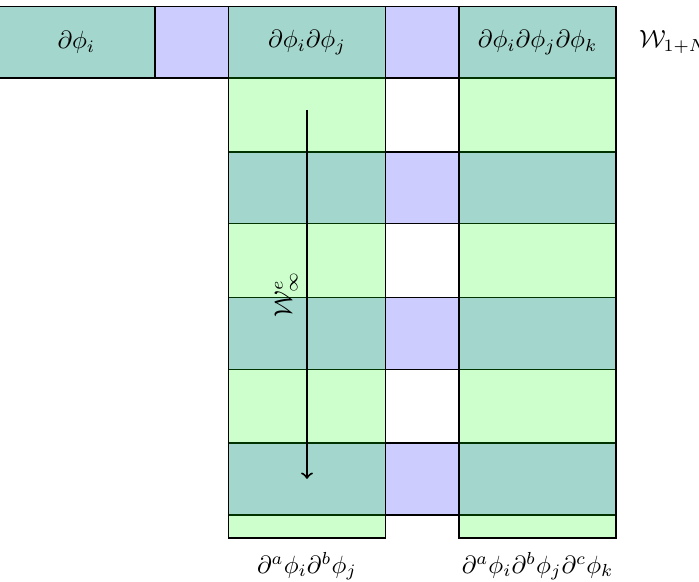
Figure 2 . The operators in the top-most row realize the generated by acting by derivatives on the constituent terms of each column corresponds to the symbol for the terms in the top